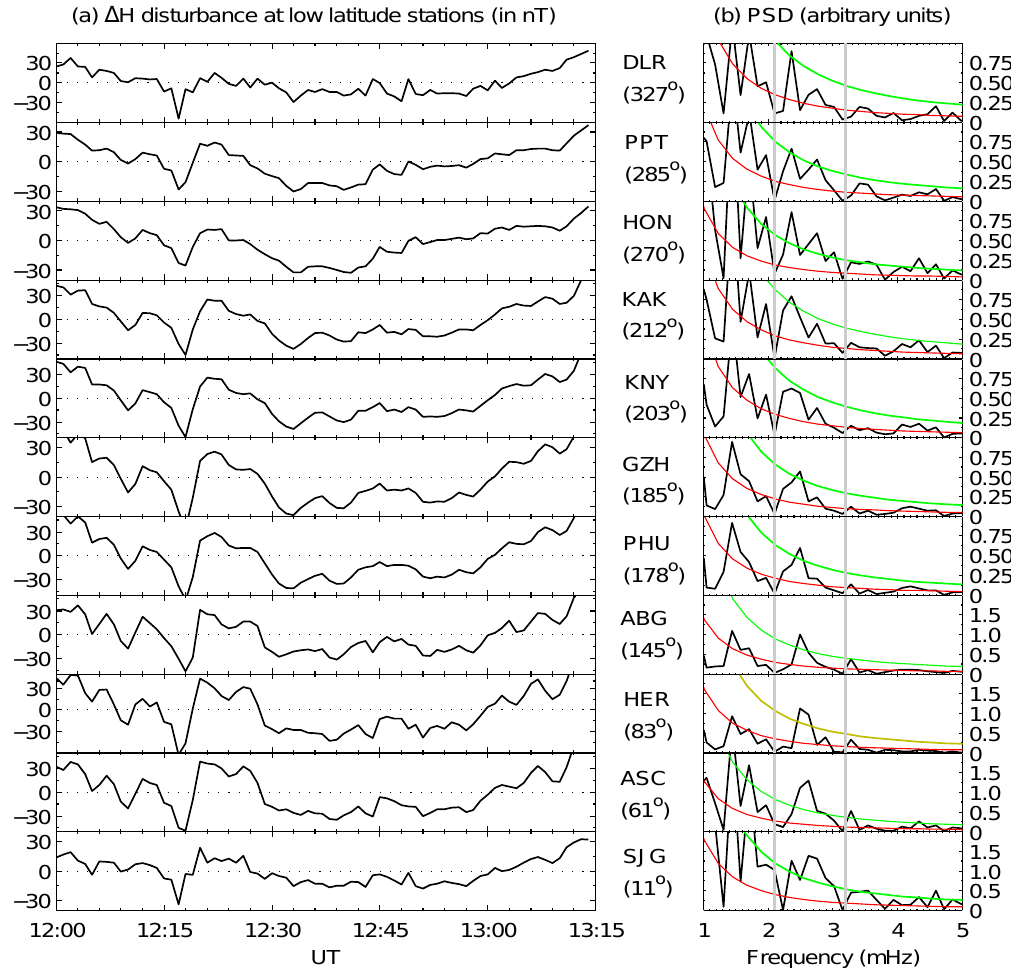
Fig. 6. Same as Fig. 2 but in time interval 12:00–13:15UT on 31 October 2005. Frequency range 2.1–3.2mHz is selected due to globally high and statistically significant spectral peaks in this band around the